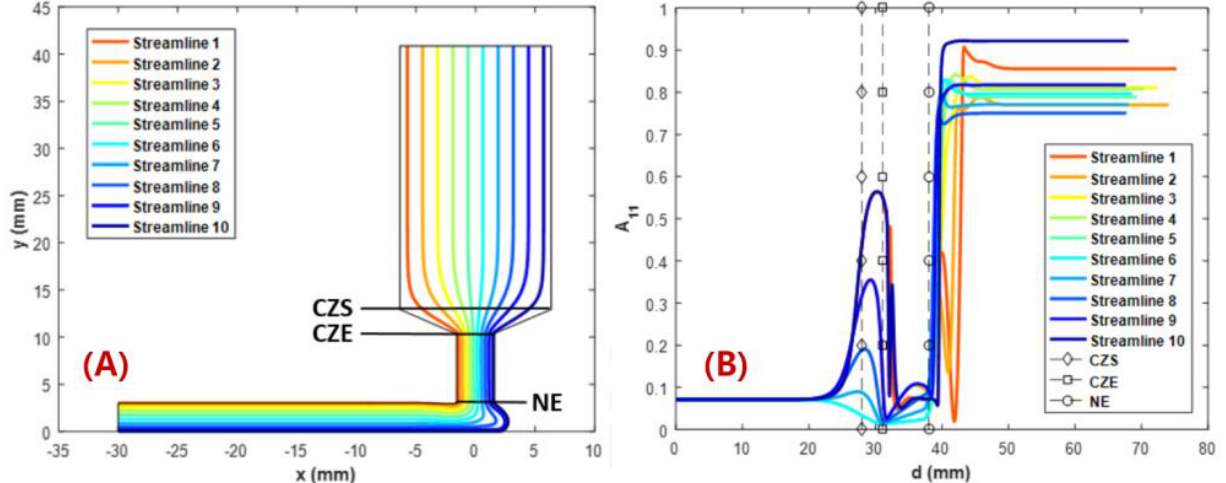
Figure 8. ( A ) Ten Evenly Spaced Streamlines for Three Flow Regimes.; ( B ) Fiber Alignment in the x Direction for Level Flow, A 11 [110].